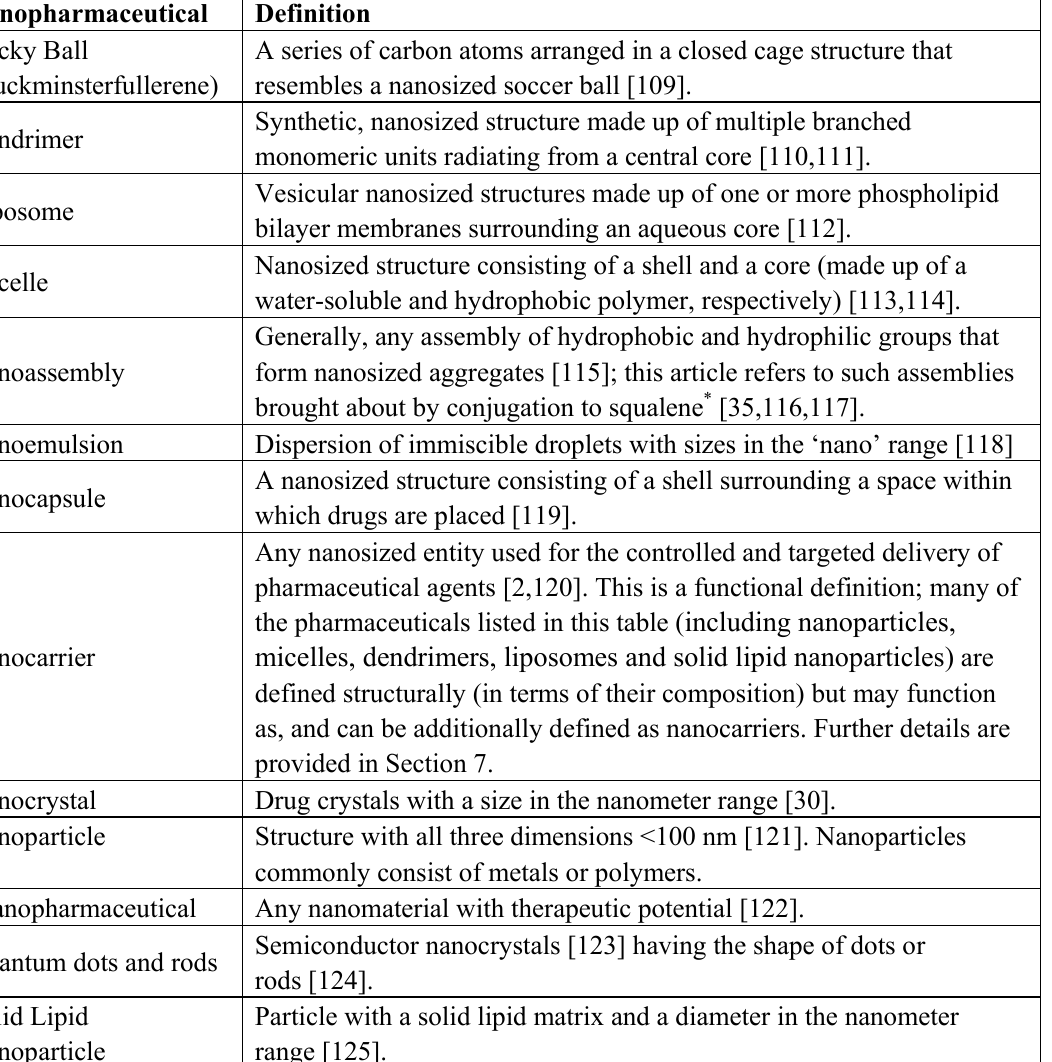
Table 2. Nanopharmaceuticals